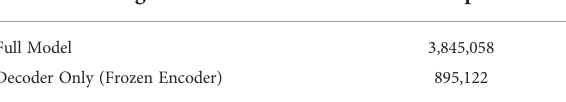
TABLE 5 UNet-2.5D parameter comparison.